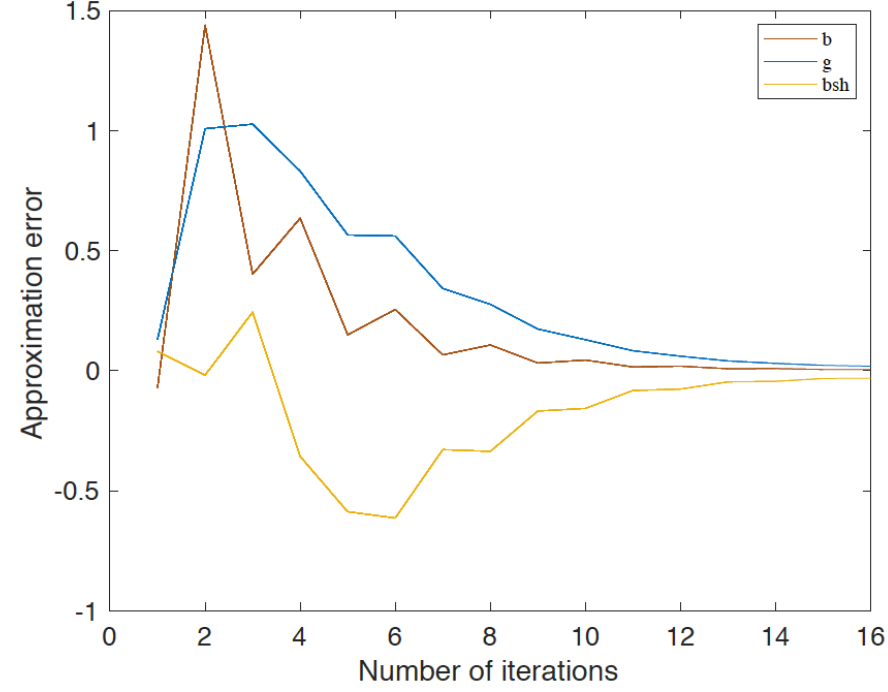
Figure 5. Correction for line 23–32.